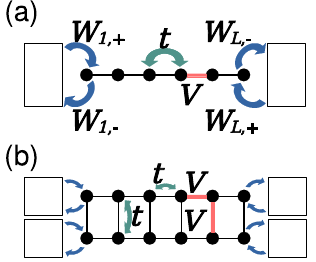
Fig. 1 Schematics of the studied models. Fermion chain ( a ) and fermion ladder ( b